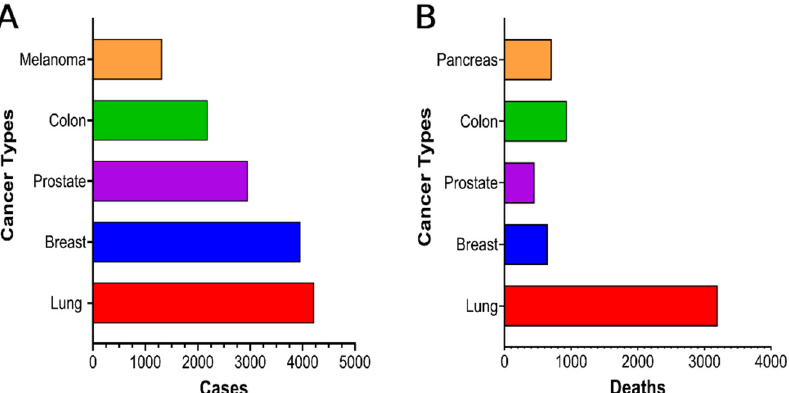
Figure 1. The top five cancer incidences in Alabama. ( A ) shows Alabama’s top five cancer cases, while ( B ) indicates Alabama’s top five cancer deaths. Prostate cancer is a health disparity disease. It is among the top five in both categories (cases and deaths). Data source: Alabama Statewide Cancer Registry, Alabama Department of Public Health (2020) [2], accessed on 12 February 2022. Table 1. Alabama and the United States prostate cancer incidence rates by race. Category Alabama Unites States All Races 119.4 104.7 White 97.4 95.4 Black 185.7 169.5